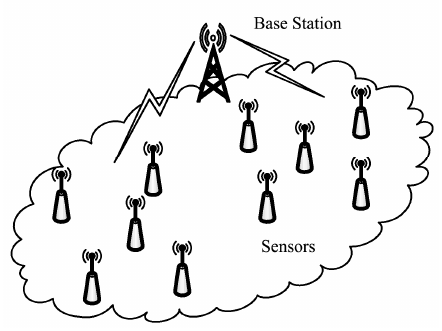
Figure 1. Application of wireless sensor networks.